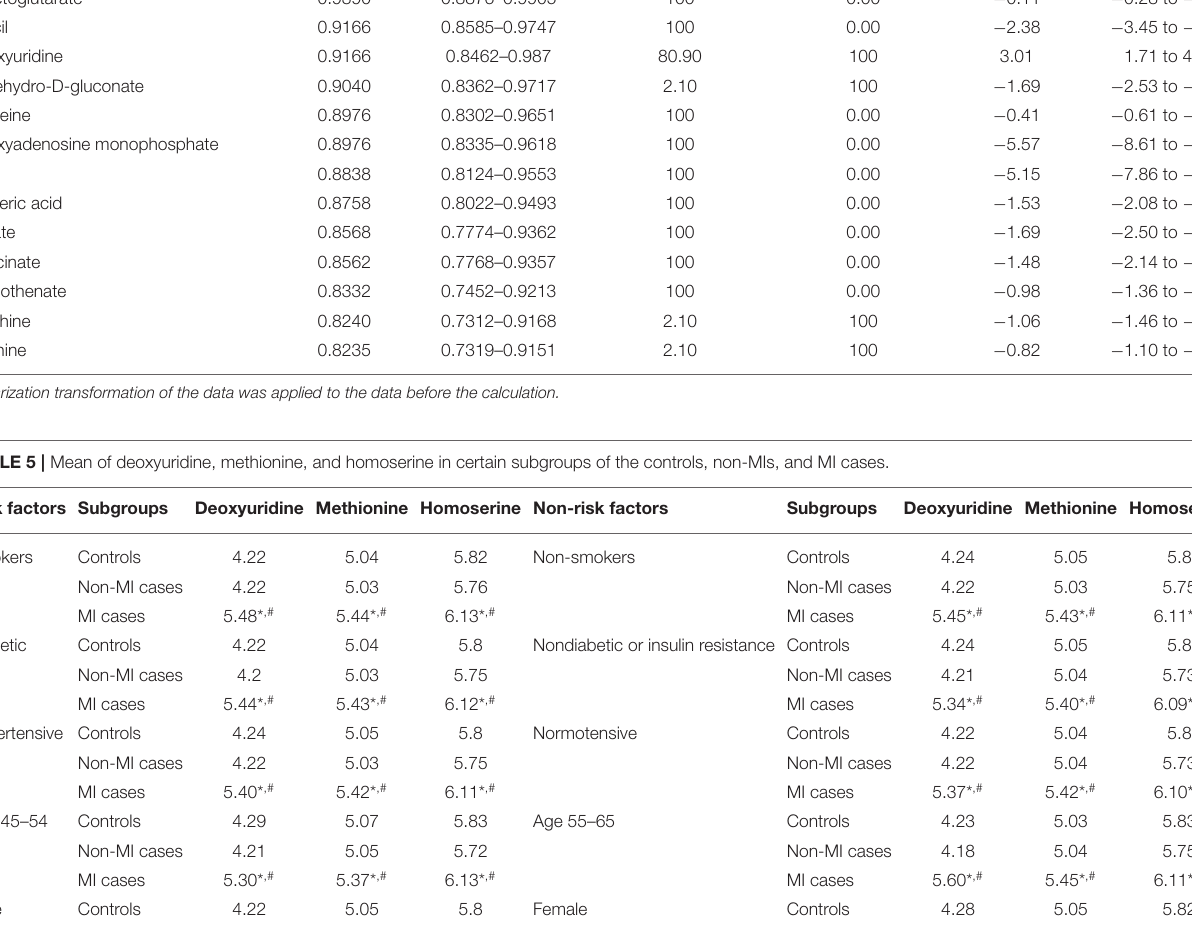
TABLE 4 | Differential metabolites and the diagnostic potential between MI and non-MI chest pain cases. Differential metabolites